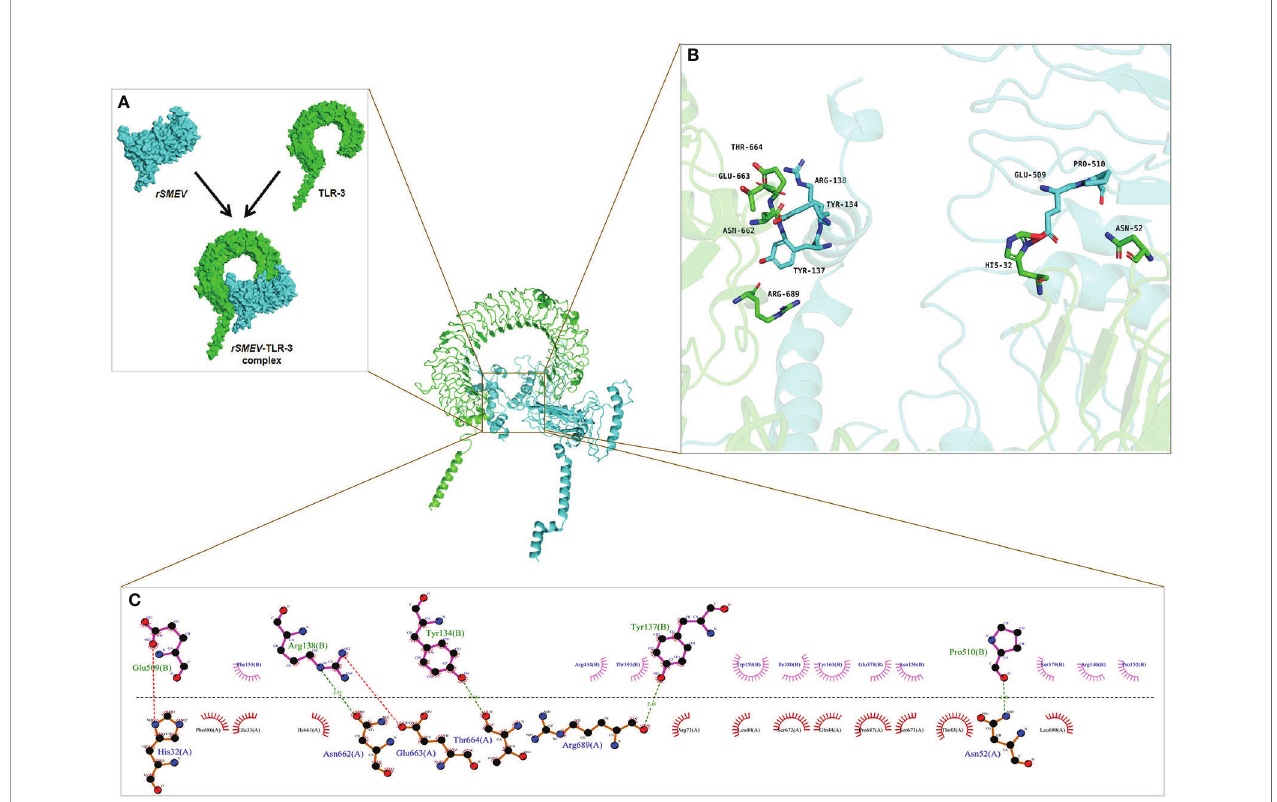
FIGURE 11 | The molecular docking of rSMEV with TLR-3. (A) Schematic diagram of docking between vaccine molecule rSMEV and antigen recognition molecule TLR-3. The rSMEV is light blue and TLR-3 is green. After docking, the rSMEV -TLR-3 complex was formed. (B) The interaction interface predicted by the PyMol is three-dimensional. In this three-dimensional interaction interface, it is mainly ionic bond and hydrogen bond that participate in the interaction. (C) The interaction interface predicted by the Ligplot is two-dimensional. And in this two-dimensional interaction interface, the red dotted line represents ionic bond and the green dotted line represents hydrogen bond, so there are 2 ionic bonds and 4 hydrogen bonds involved in the